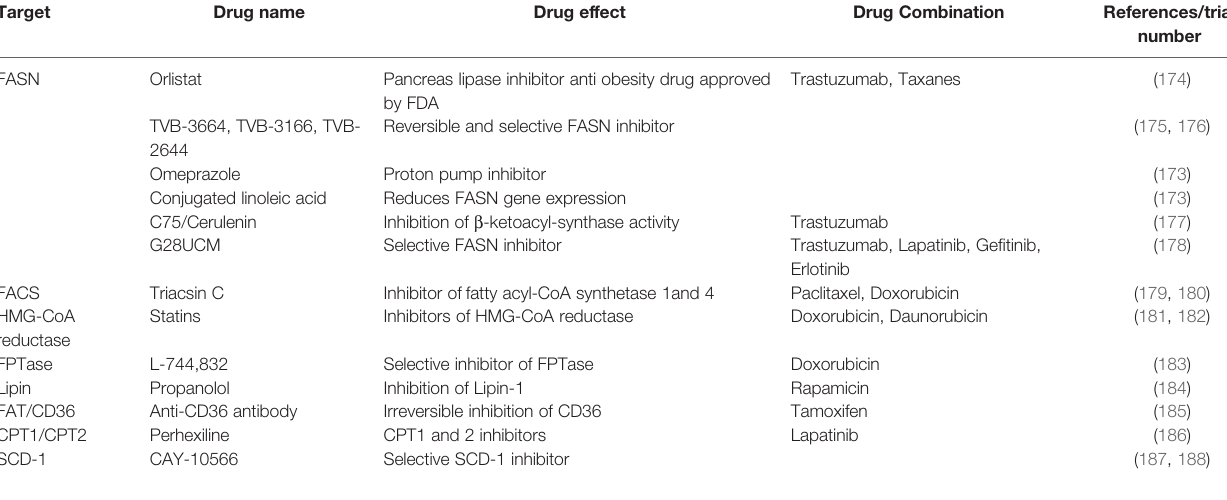
TABLE 4 | Non-exhaustive list of drugs targeting lipid metabolism used in association with standard treatments in resistant cancer.